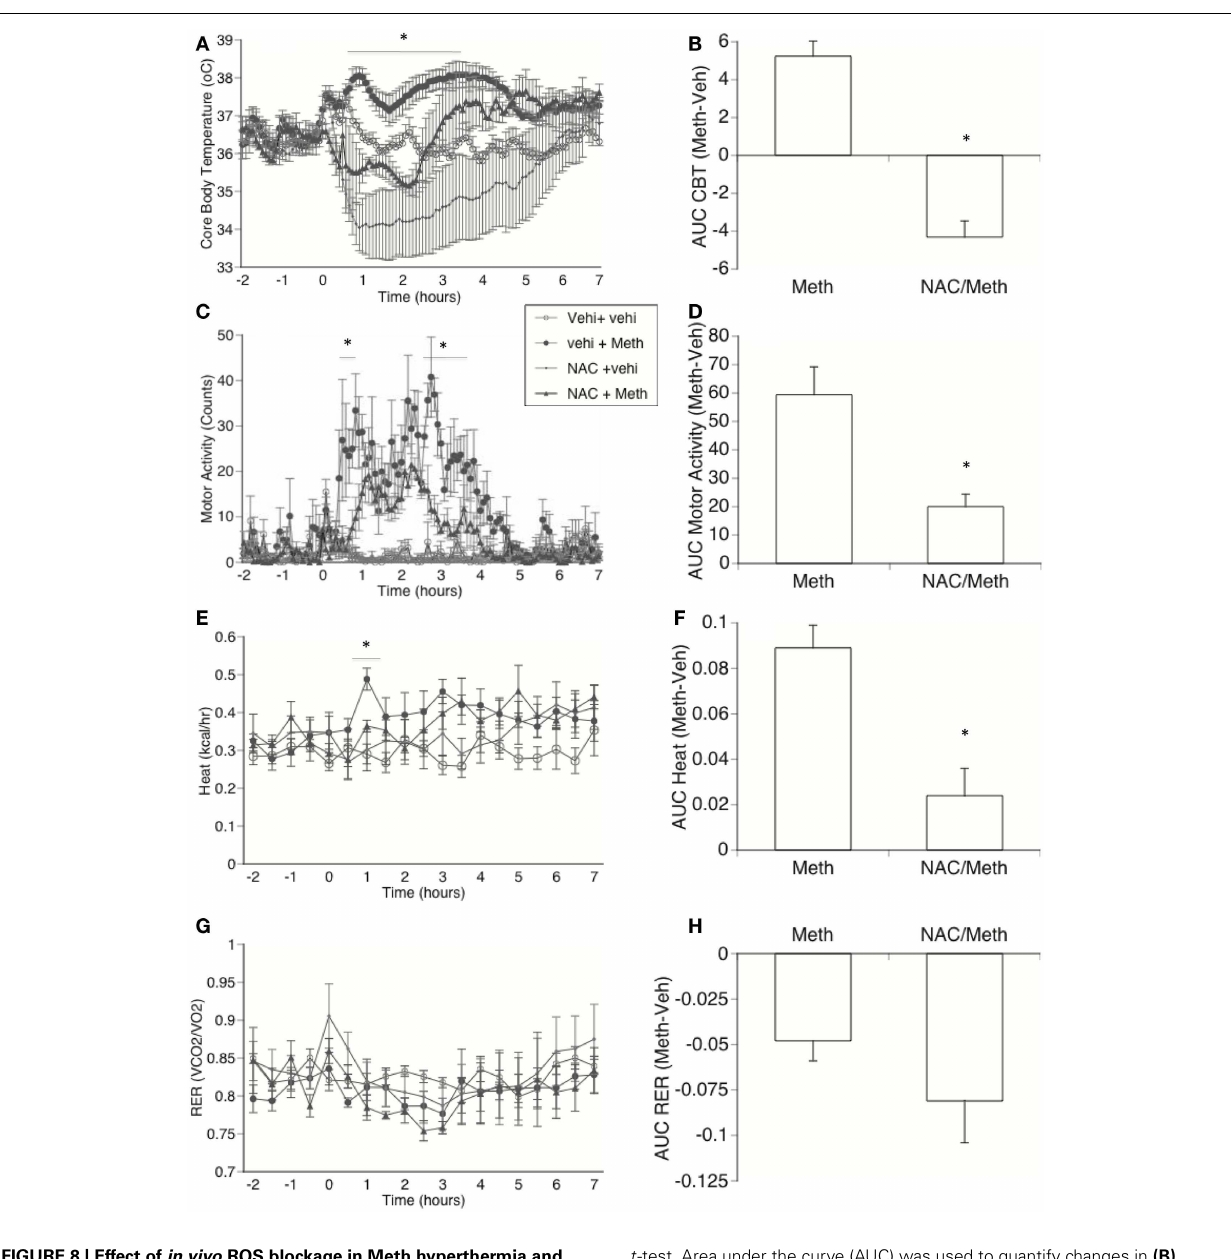
FIGURE 8 | Effect of in vivo ROS blockage in Meth hyperthermia and metabolic parameters. Mice implanted with telemetry devices were IP-treated with NAC (1000mg/kg) or vehicle 60min before the injection of Vehicle or Meth (3mg/kg), and were evaluated during 6h for core body temperature (A) , motor activity (C) , Heat production (E) , and RER (G) . Stress peak (first hour) was excluded.Values represent the average ± SEM of four animals/group. * p < 0.05 compared to NAC control, n = 4, Student